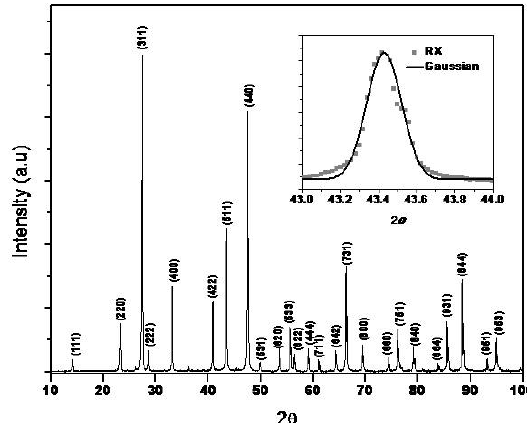
S . Figure 1. Profile of the XRD spectrum of the compound AgIn 5 8 The lineshape of the diffraction peaks correspond in general to a Gaussian profile, as observed from the inserted figure. On the other hand, the XRD spectra for AgIn Se and 5 8 AgIn Te are shown in Figs. 2-3 and are in agreement with 5 8 results published earlier. 26,27 Both systems display tetragonal structures with lattice parameters a = 5.795224 Å, c = 11.622806 Å in AgIn Se , and a = 6.2120 Å, c = 12.4561 Å in AgIn Te ; 5 8 5 8 with characteristic c / a 2.005 tetragonal distortion in both samples. As in the case of AgIn S these profiles are almost 5 8 ≅ Gaussian, as is demonstrated by the continuous curves shown in the inserted panels. This fact assures that the FWHM of the XRD profile and the diffraction angle satisfy the relation (13).